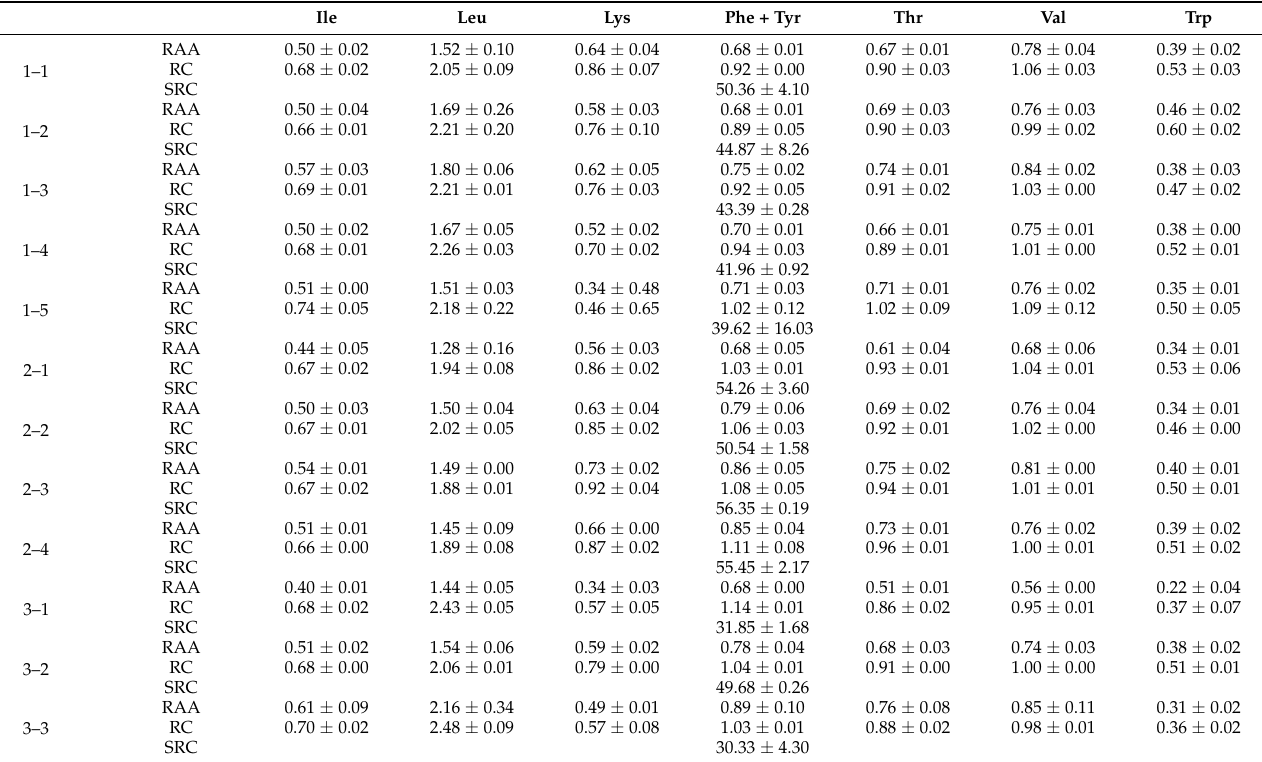
Table 12. RAA, RC, and SRC of egg amino acid standard pattern spectra from three